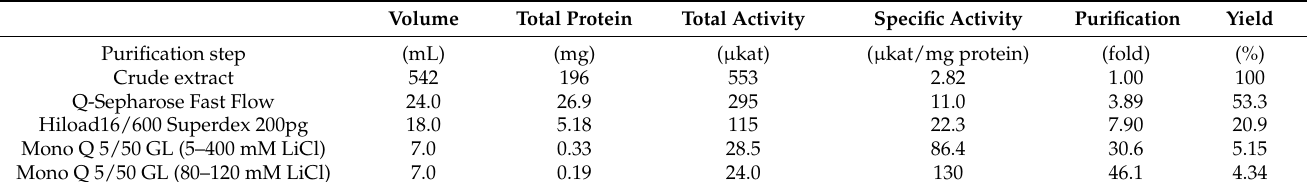
Table 1. Summary of purification of rutinosidase from FC seeds.